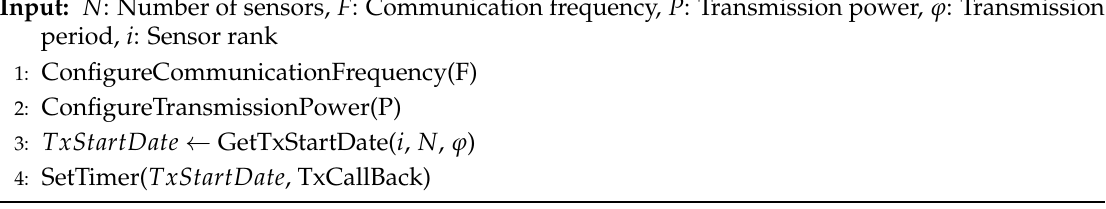
Algorithm 1 Sensor initialization—called at sensor